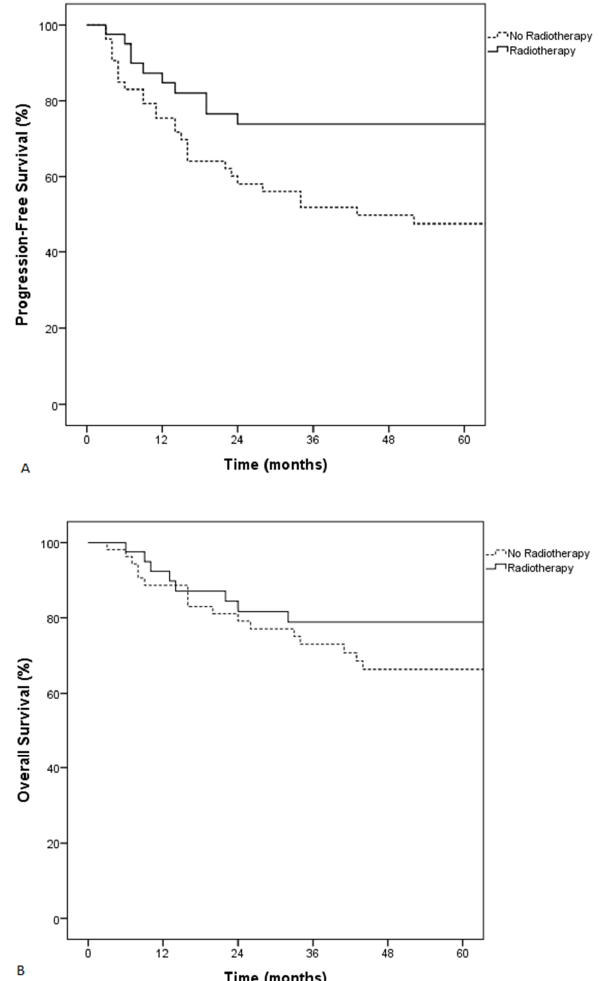
Figure 3. Progression-free survival (PFS) ( A ) and overall survival (OS) ( B ) of patients treated with or without radiotherapy. PFS and OS (HR: 0.3, 95% CI: 0.1–0.8, p = 0.01 and HR: 0.3, 95% CI: 0.1–0.8, p = 0.02, respec- tively).